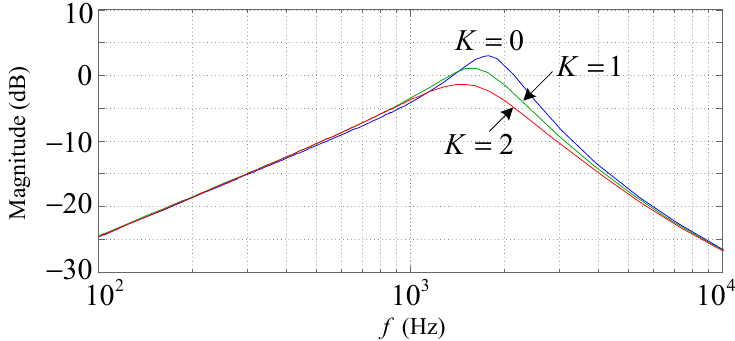
Figure 9. Magnitude characteristic of the resonance damping system.